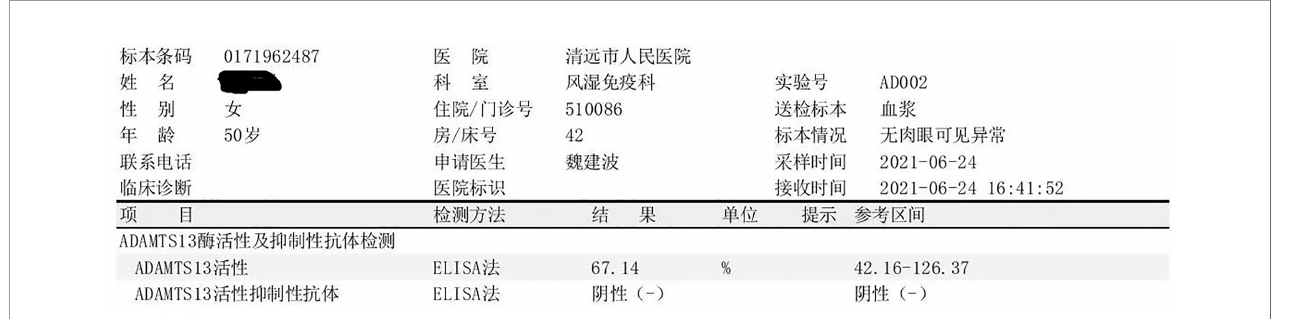
FIGURE 4 | The result of ADAMTS13 autoantibodies and ADAMTS13 inhibitory autoantibodies after